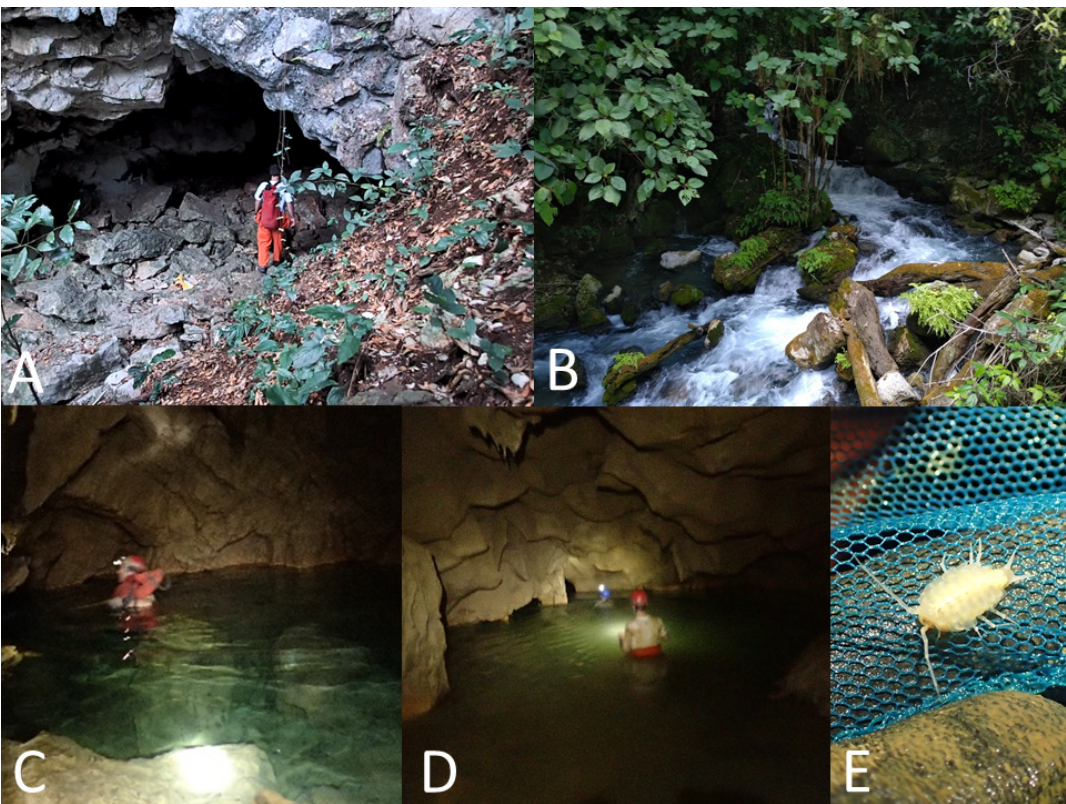
Figure 13. Cueva del Fraile in the Tamasopo area. Despite this cave apparently having habitats perfectly suited for Astyanax cavefish, none were found. ( A ); Entrance to Fraile cave. ( B ); year-round active resurgence near Cueva del Fraile. ( C , D ); Cueva del Fraile has many pools and lakes. ( E ); Aquatic cave-adapted isopod found in some of these pools. Notice that the roof on D is covered with mud, and shows erosion typical of passages where water reaches the ceiling during the rainy season. Galleries are typically at least 5 m high and wide. A few meters after the penumbra zone, a left trending gallery bifurcates. This is the shortest gallery. Several permanent pools are crossed, until a sump is encountered. In the right gallery a maze-like section divides again into two main galleries.